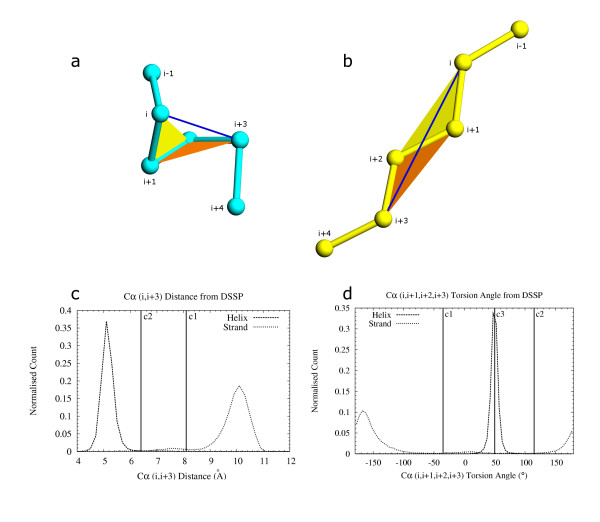
Parameters for assignment of helix and β-strand property to individual residues. Cα distance and Cα torsion angle were calculated for defining helices (fig. a) and β-strands (fig. b). The distance between residues i, i+3 (shown joined by a blue line) and torsion angle between residues i, i+1, i+2, i+3 (shown as angle between two colored planes; yellow plane between residues i, i+1, i+2 and orange plane between residues i+1, i+2, i+3) are used to assign loose-helix, strict-helix and loose-strand secondary structure property to individual residues. 4c: Distance between i, i+3 Cα residues from helix and β-strand definitions obtained from DSSP [8] output. Distances were binned in 0.2 Å intervals. Cutoff distance c1 (8.1 Å) is the maximum distance allowed for assigning loose-helix property to a residue. Cutoff c1 is also the minimum distance allowed for assigning loose-strand property to a residue. Residues at i and i+3 positions are allowed in the same SSE template (SSET) only if the cutoff distance c1 passes. Cutoff c2 (6.4 Å) is the maximum i, i+3 Cα distance for strict helix definition. 4d: Torsion angle between i, i+1, i+2, i+3 Cα atoms for helix and β-strand definitions obtained from DSSP output. Angles are binned in 5° intervals. A loose-helix definition is assigned to a residue only if the torsion angle for the residue falls between c1 (-35°) and c2 (115°). A loose-strand is assigned only if the torsion angle is -180° to c1 or c2 to 180°. c3 is the optimal torsion angle for helices and is used to define strict-helix residues if the torsion angle is within a 2 sigma deviation from c3.